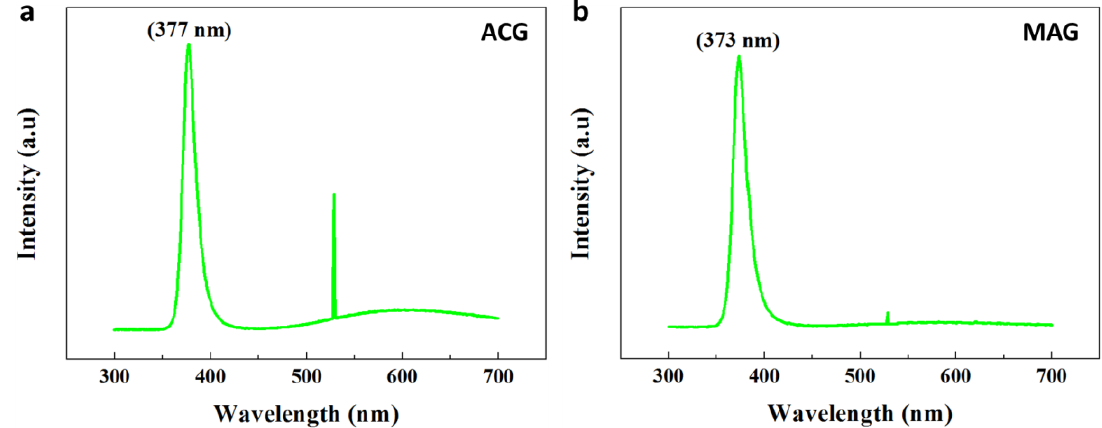
Figure 6. ZNR Photoluminescence spectra: ( a ) the ACG and ( b ) the MAG method.